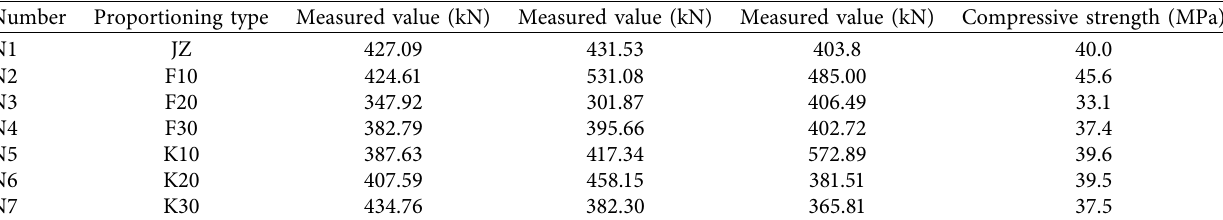
Table 5: Test results of compressive strength of C30